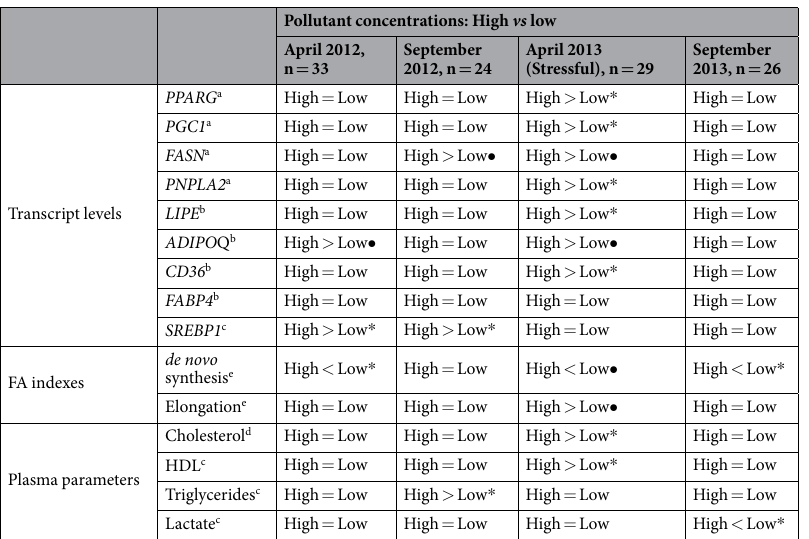
Table 2. Combined effects of sea ice and pollutants on energy metabolism. Energy metabolism response to High or Low pollutant concentrations during stressful (spring 2013) and non-stressful (spring and autumn 2012, autumn 2013) sampling periods. We used spring 2013 as a reference “stressful period”. For each group of pollutant (best predictor according to AICc), the data set was split into two classes separated by the median pollutant concentration, resulting in one high and one low polluted group for each individual or group of pollutants. “High” refers to more polluted females with pollutant and “Low” to less polluted females. Pollutants used for high - low classification: a Σ ( 13 PCBs, oxychlordane), b Σ (PCB-118, trans -nonachlor), c Σ 6 PFCA, d